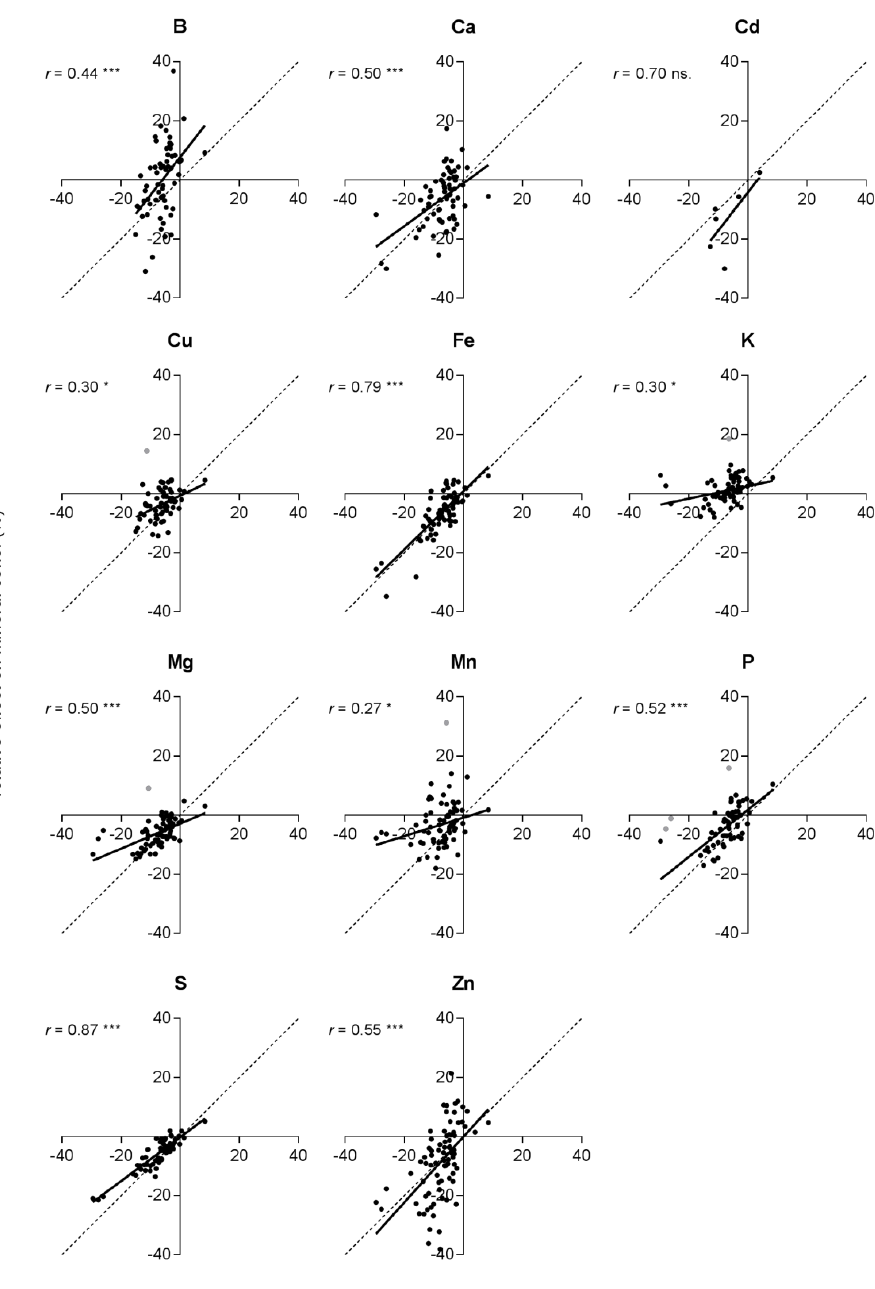
Figure 6. Relative effect of eCO 2 on mineral concentration (B, Ca, Cd, Cu, Fe, K, Mg, Mn, P, S, and Zn) related to the relative effect on N concentration. Correlation coefficient ( r ) and its significance is presented in each plot. Black solid lines represent the linear regression model, for which parameters and model performance are presented in Table 2. Grey markers show data points identified as outliers not included in the curve fitting. Dashed lines represent the hypothetical situation where the effect of eCO 2 on mineral concentration is equal to the effect on N concentration.